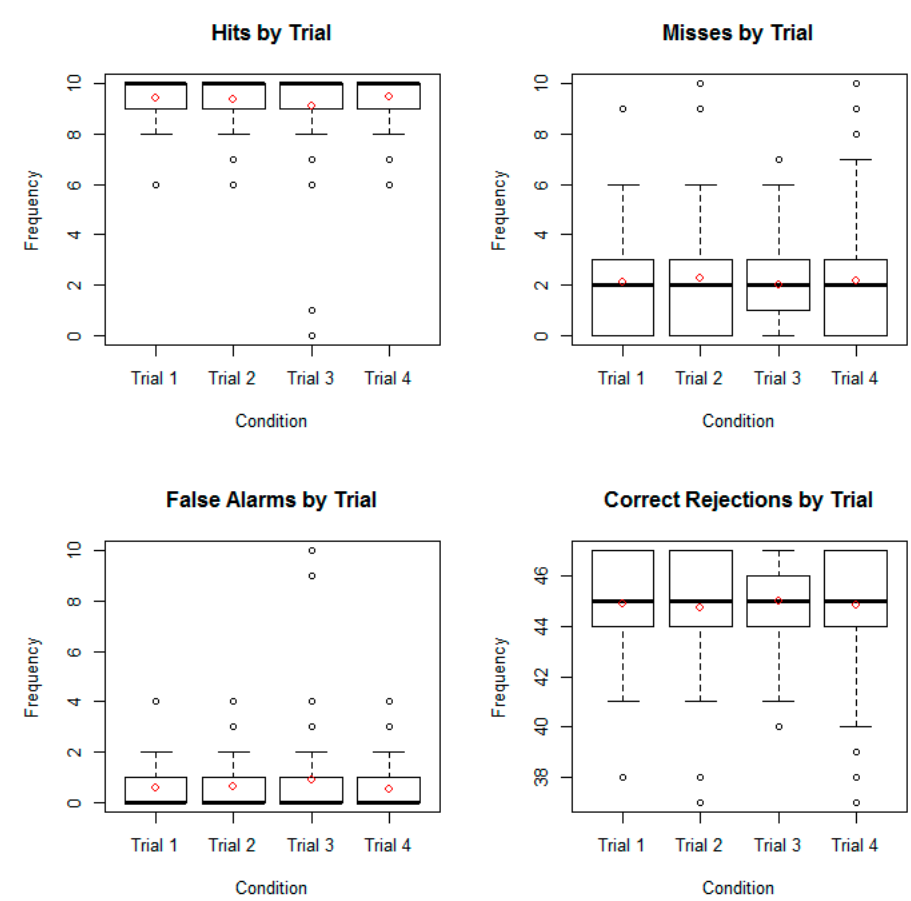
Figure 8. Hits, misses, false alarms and correct rejections by trial.